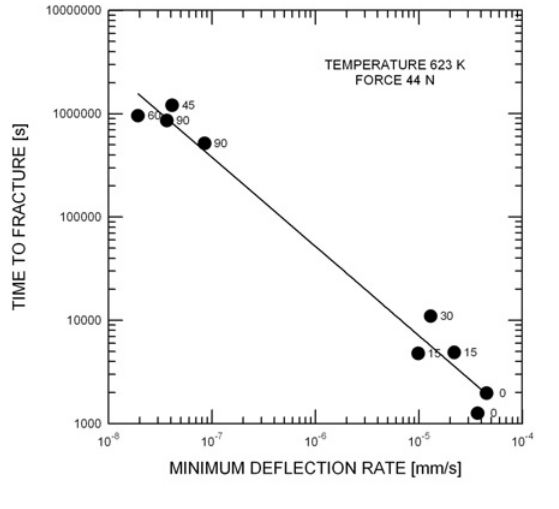
Figure 8. Dependence of time to fracture on minimum de- flection rate for constant force and different orientation angles.